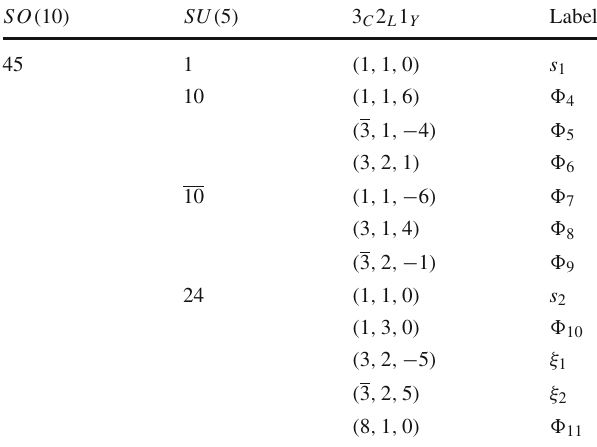
Table 5 Decomposition of the scalar 126 representation of SO ( 10 ) with respect to the subgroups SU ( 5 ) and SU ( 3 ) C × SU ( 2 ) L × U ( 1 ) Y . For further details, see Table